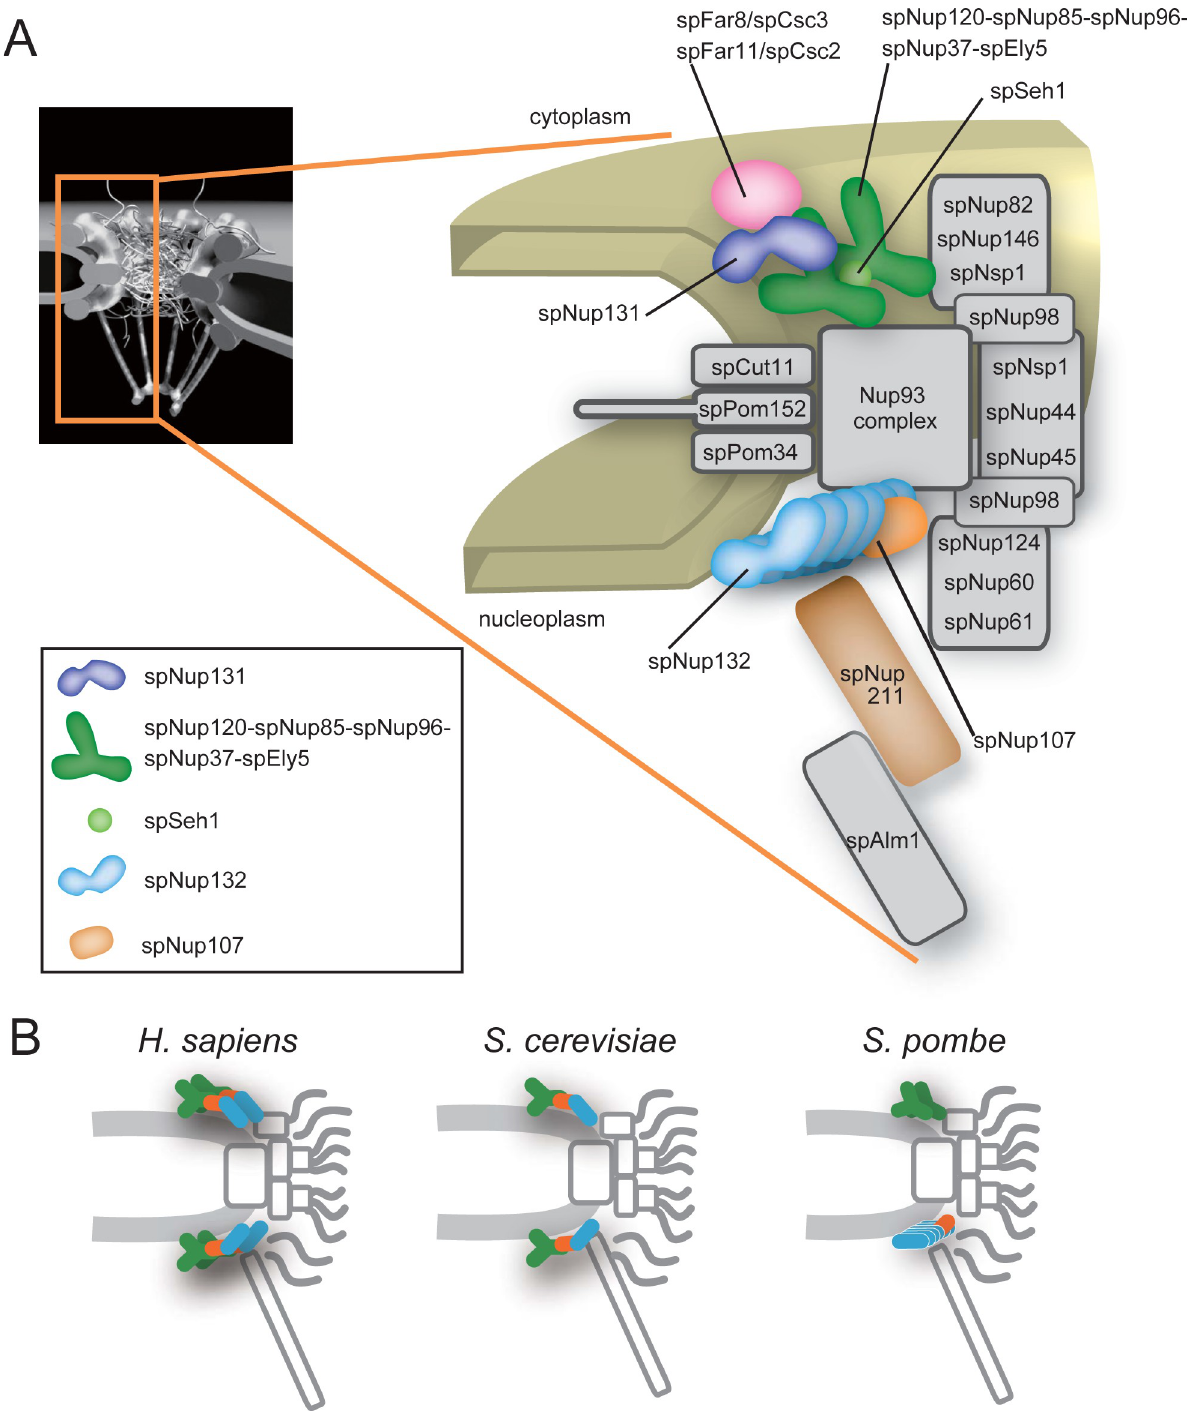
Fig 8. Model of the S . pombe NPC. (A) Positions of the S . pombe Nups. The numbers of the Nup107-160 subcomplex components were deduced based on the FM and biochemical analysis reported previously [29]: spNup131 (1 molecule, dark blue), the spNup120-spNup85-spNup96-spNup37- spEly5 complex (2 molecules each, dark green), spSeh1 (1 molecule, light green), spNup107 (1 molecule, orange), spNup132 (6 molecules, right blue). (B) Schematic drawings of the NPC structure in H . sapiens (left) [5] and S . cerevisiae (middle) [26] in comparison to that in S . pombe (right).